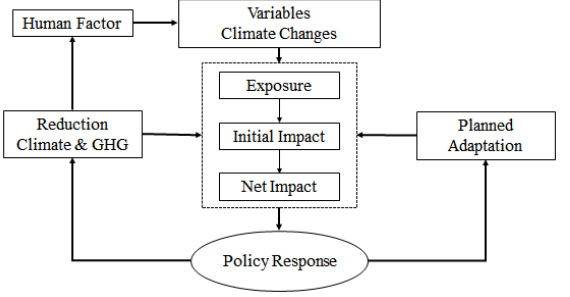
Figure 7. Possible framework showing variety of variables of climate changes on crop production. Source:[126].